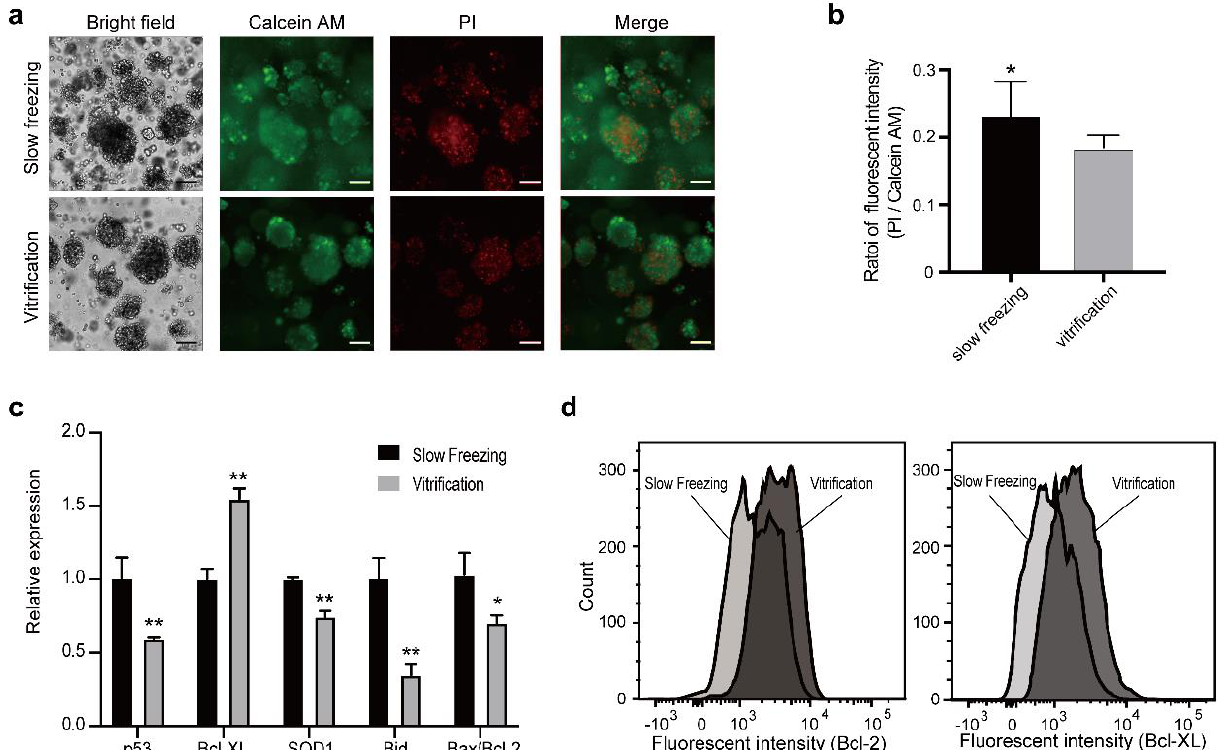
Figure 4. LCOs in the vitrification group maintained higher viability compared to LCOs in the slow freezing group. ( a ) Live/dead cell staining of LCOs in both groups (green: live cells, red: dead cells). Scales bars: 100 µm. ( b ) Quantification of the live/dead assay (two-tailed Student’s t -test, data are presented as mean ± SD, * p < 0.05). ( c ) RT-qPCR analysis of apoptosis-related genes and oxidative stress-related genes (two-tailed Student’s t -test, data are presented as mean ± SD, * p < 0.05, ** p < 0.01). ( d ) Flow cytometry measurement of the anti-apoptosis genes Bcl-2 and Bcl-XL.